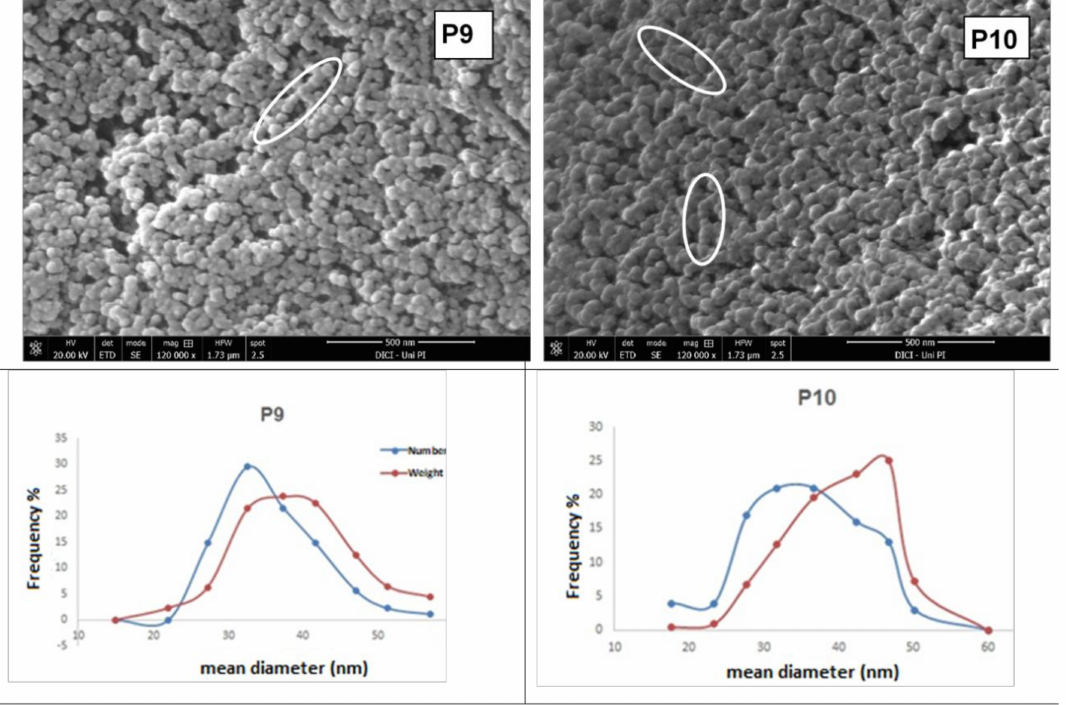
Figure 7. Above: SEM micrographs of dried powders from samples P9 ( left ) and P10 ( right ) with the corresponding particle size distributions below (the red line connects the weight-averaged frequency, the blue line the volume averaged-frequency) from particle counts and sizing obtained through image analysis. Circles evidence “chain-like” assemblies of